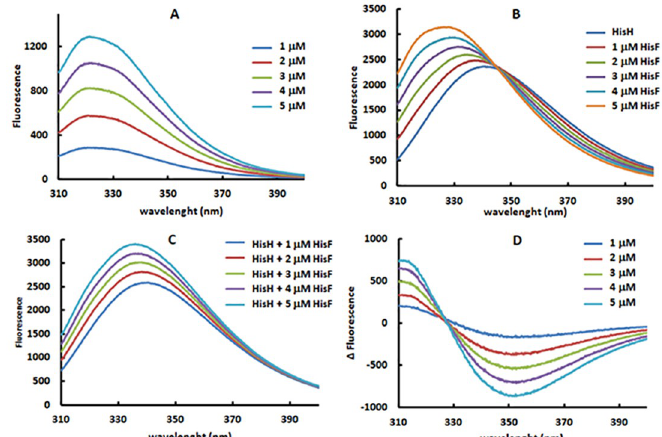
Fig 3. Intrinsic fluorescence spectra used in the determination of the dissociation constant of the HisF-HisH heterodimer. A) Fluorescence spectra of different concentrations of HisF. B) Fluorescence spectra collected along the mixing of 15 μ M HisH with sub-stoichiometric HisF concentrations (1 to 5 μ M). C) Arithmetical addition spectra combining the fluorescence of HisH (from B) with the fluorescence of different HisF concentrations (from A). D) Difference spectra calculated based on the arithmetical subtraction of the “addition spectra” (C) from the “mixing spectra” (B).